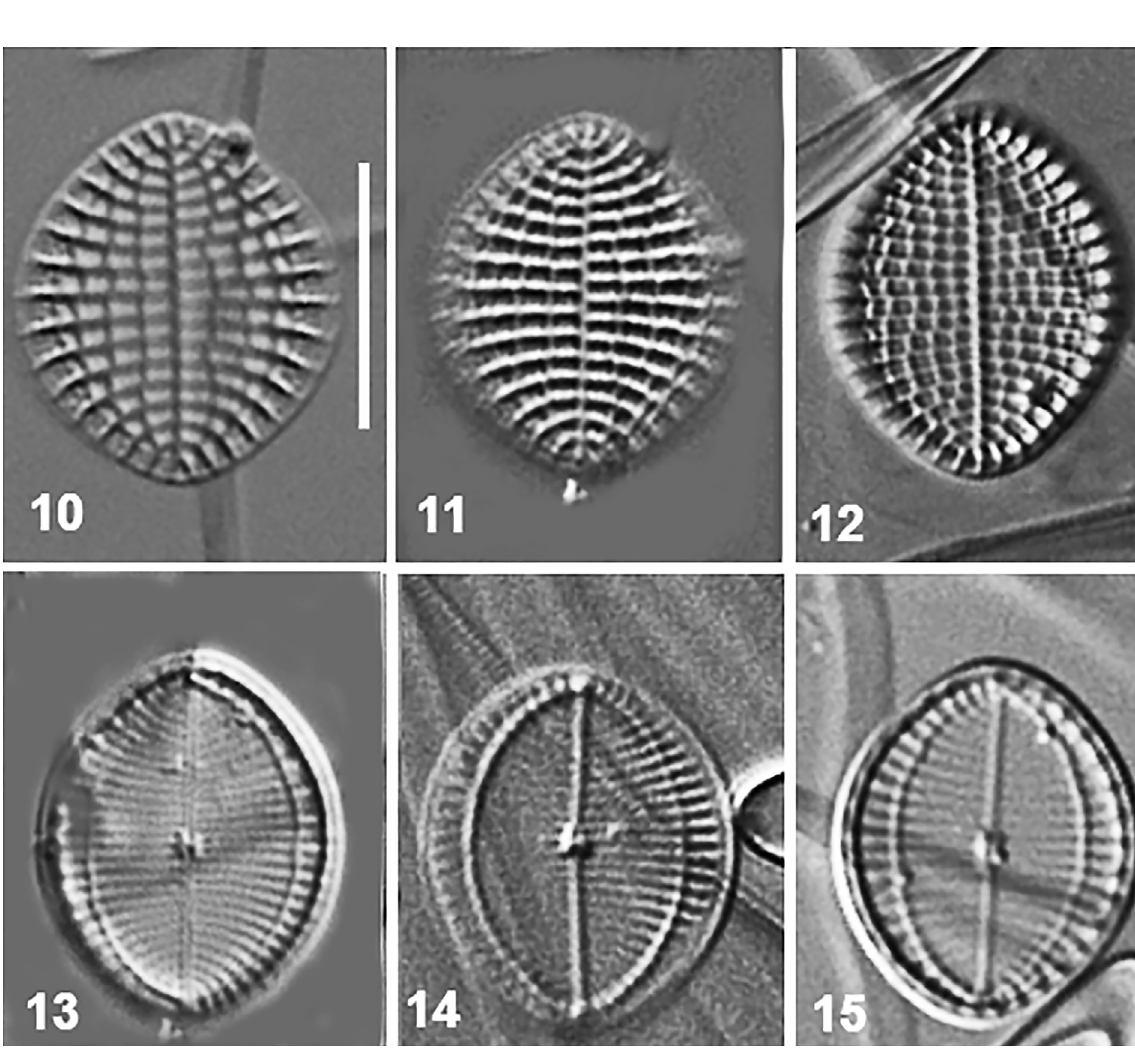
Figs 10–15. SEM images of Cocconeis vrangoensis Al-Handal & Riaux-Gob. sp. nov. (BGBM, slide B 40 0043105). 10–12 . SV. 13–15 . Internal side of the RV, showing variations in valves size and outline. Scale bar: 10